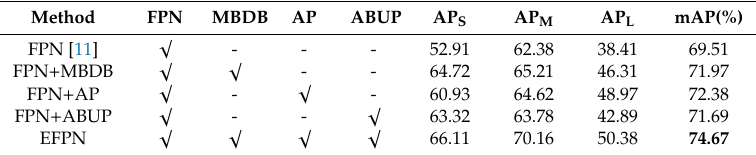
Table 2. The comparison results for the FPN and EFPN on the DOTA-v1.5 validation dataset. FPN: